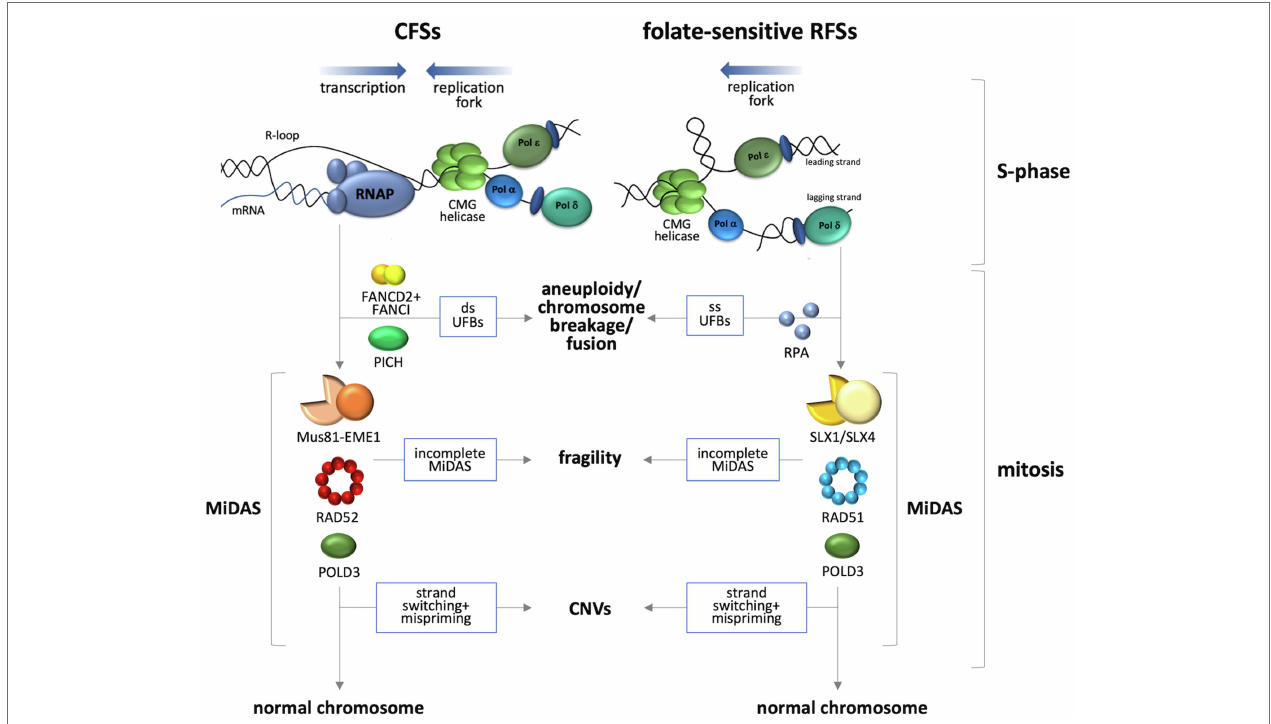
FIGURE 1 | Current models for events occurring at loci containing APH-inducible and folate-sensitive FSs. APH-inducible sites are difficult to replicate, a situation that may be exacerbated by collisions between the replication fork and the transcription complex. A head-on collision is depicted here since it is associated with elevated levels of DSBs as well as the formation of R-loops (Hamperl et al., 2017) suggested to be important for fragility of these sites (Helmrich et al., 2011). Folate-sensitive RFSs are associated with replication problems resulting from the formation of a fork blocking lesion at a locus that is transcriptionally silent. Rescue of the stalled replication forks occurs by MiDAS that involves two different BIR subpathways (Wyatt et al., 2013; Ying et al., 2013; Minocherhomji et al., 2015; Bhowmick et al., 2016; Garribba et al., 2020). Completion of MiDAS produces a normal chromosome, while failure to do so results in chromosome fragility. Strand switching during BIR that results in mispriming can result in CNVs. Failure to initiate MiDAS results in either double-stranded UFBs in the case of the APH sites (Chan et al., 2007) or single-stranded UFBs in the case of FRAXA (Bjerregaard et al.,